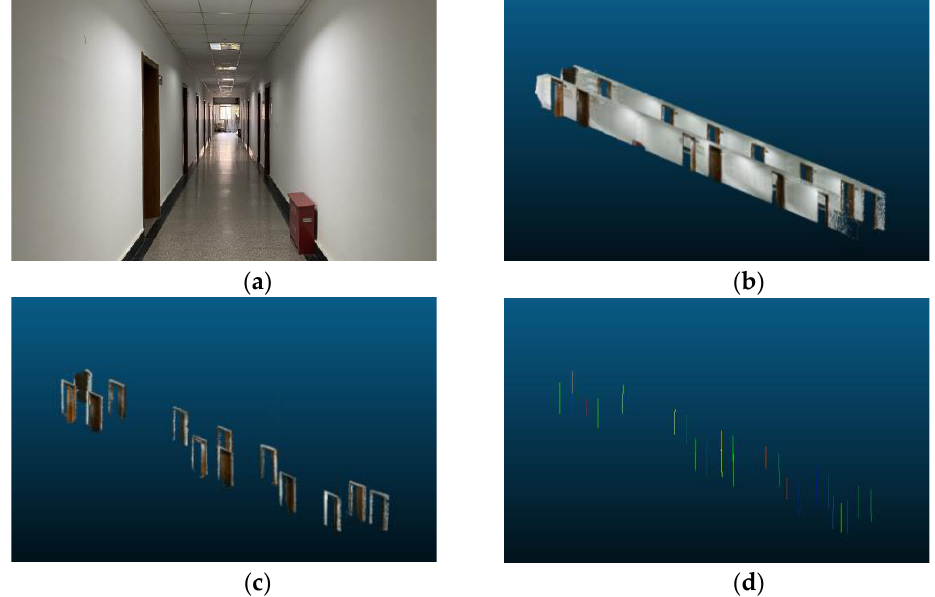
Figure 11. The point cloud map processing: ( a ) the original image; ( b ) the point cloud map of the corridor (partial); ( c ) after processing using RandLA-Net; ( d ) gate frame lines.